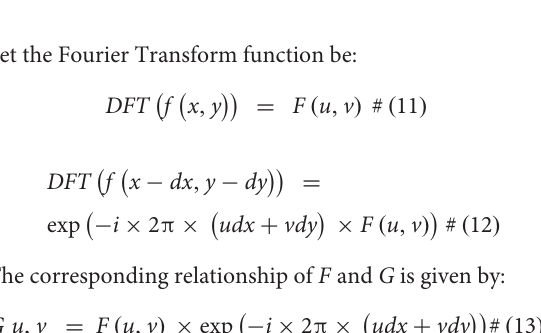
ρ : [0 , R − > [0 , rows − 1] # ( 6 max ]